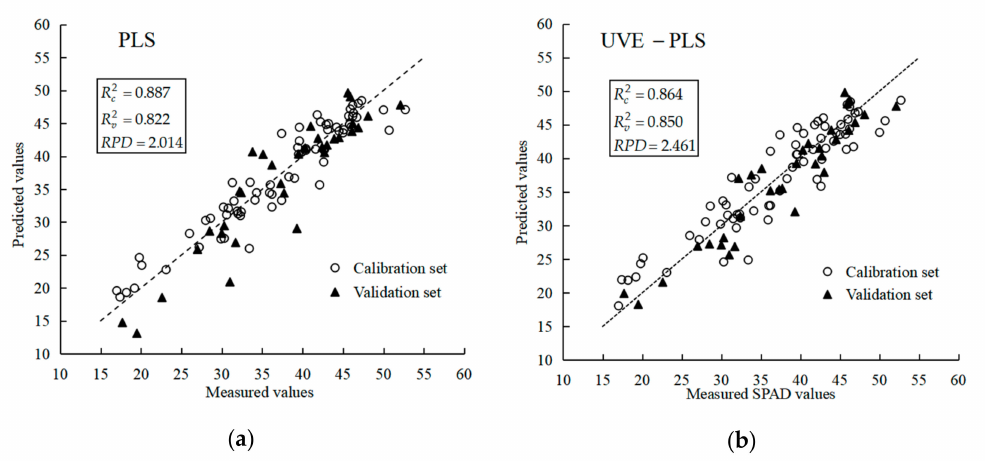
Figure 12. The prediction result of PLS and UVE–PLS models. ( a ) PLS model; ( b ) UVE–PLS